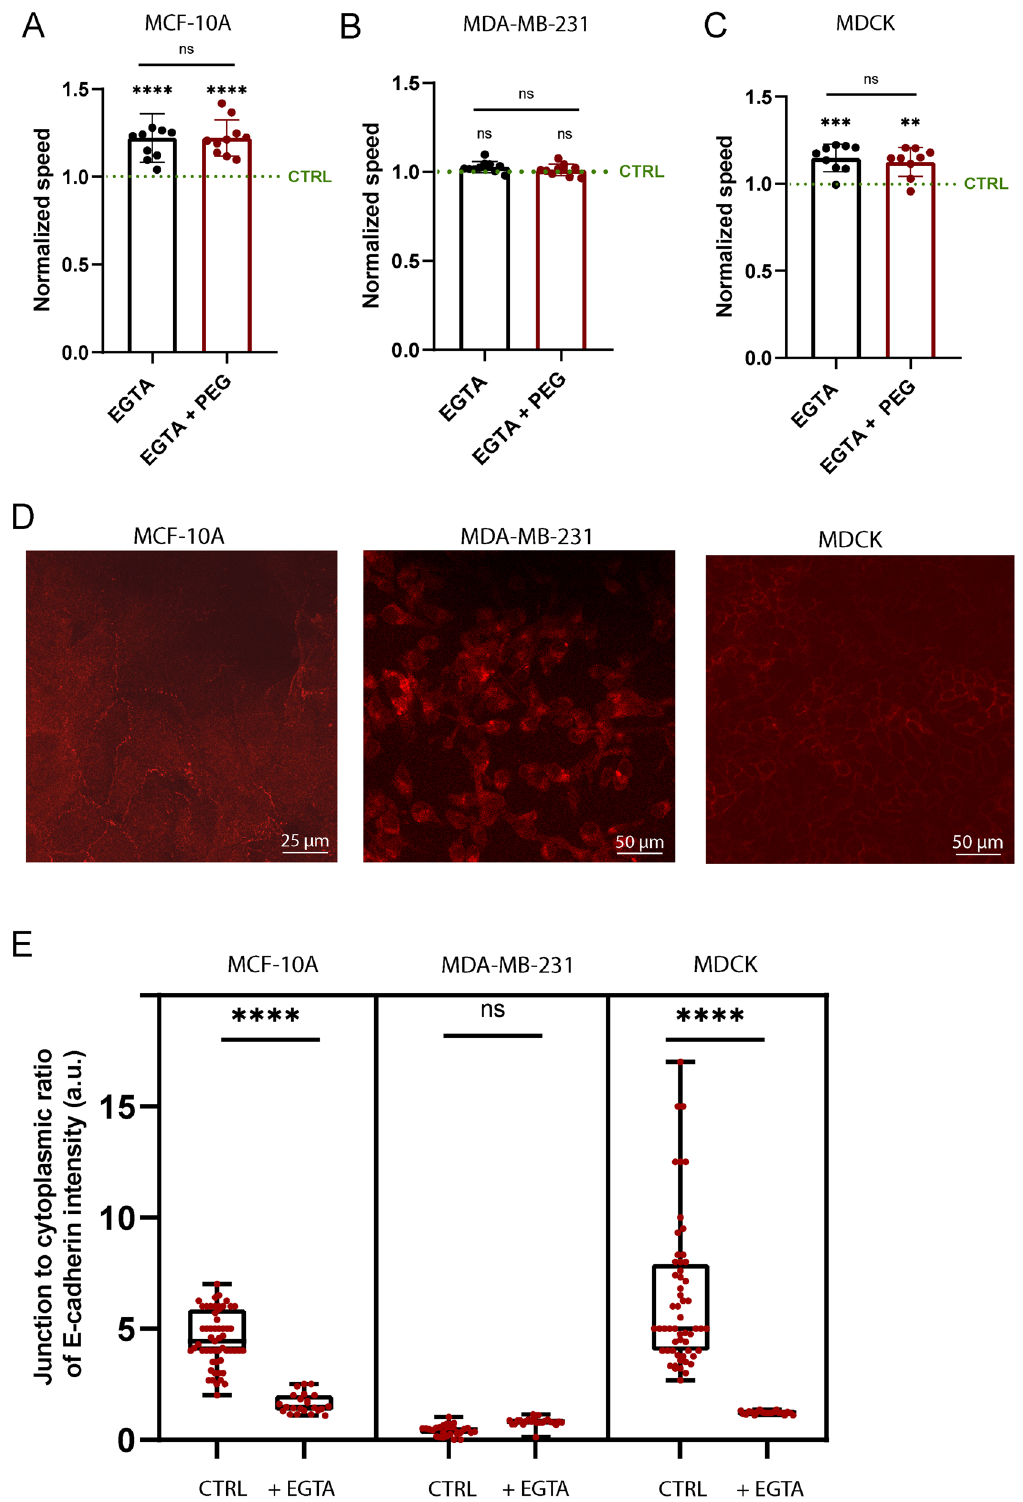
Figure 5. The effect of osmotic stress on the migratory behavior of epithelial cells is reduced by disrupting cell–cell adhesions. Average cell speed after EGTA treatment and after EGTA treatment followed by PEG 2.5% osmotic stress, both normalized with control values (without PEG and EGTA) for ( A ) MDCK, ( B ) MCF-10A and ( C ) MDA-MB-231 cell clusters respectively, with n = 9 (MDCK), n = 13 (MCF10A) and n = 10 (MDA-MB-231). ( D ) Immunostaining of E-cadherin after EGTA treatment for MCF10A, MDA-MB-231 and MDCK. ( E ) Quantification of the junction to cytoplasm ratio of E-cadherin intensity before and after EGTA treatment for MCF10-A, MDA-MB-231 and MDCK. *0.01 < p < 0.05, **0.001 < p < 0.01, ***0.0001 < p < 0.001, **** p < 0.0001 and n.s.